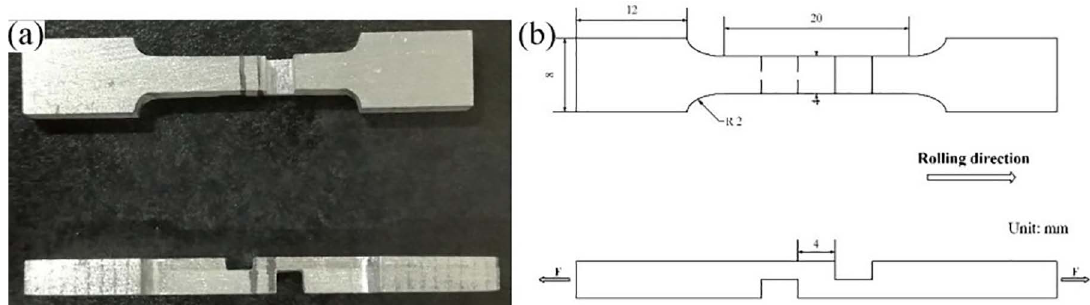
Figure 11. The photograph and dimensions of shear samples.